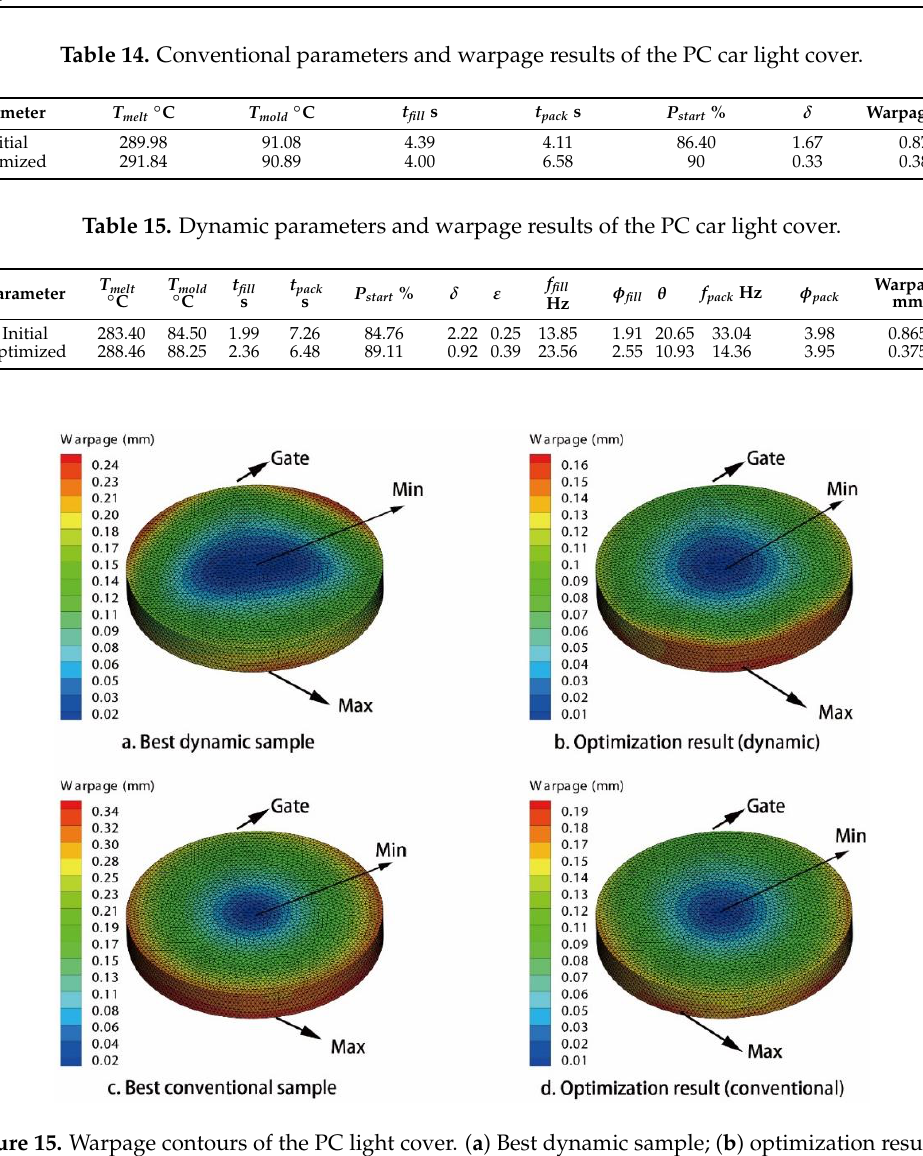
Figure 15. Warpage contours of the PC light cover. ( a ) Best dynamic sample; ( b ) optimization result of the dynamic issue; ( c ) best conventional sample; ( d ) optimization result of the conventional issue.